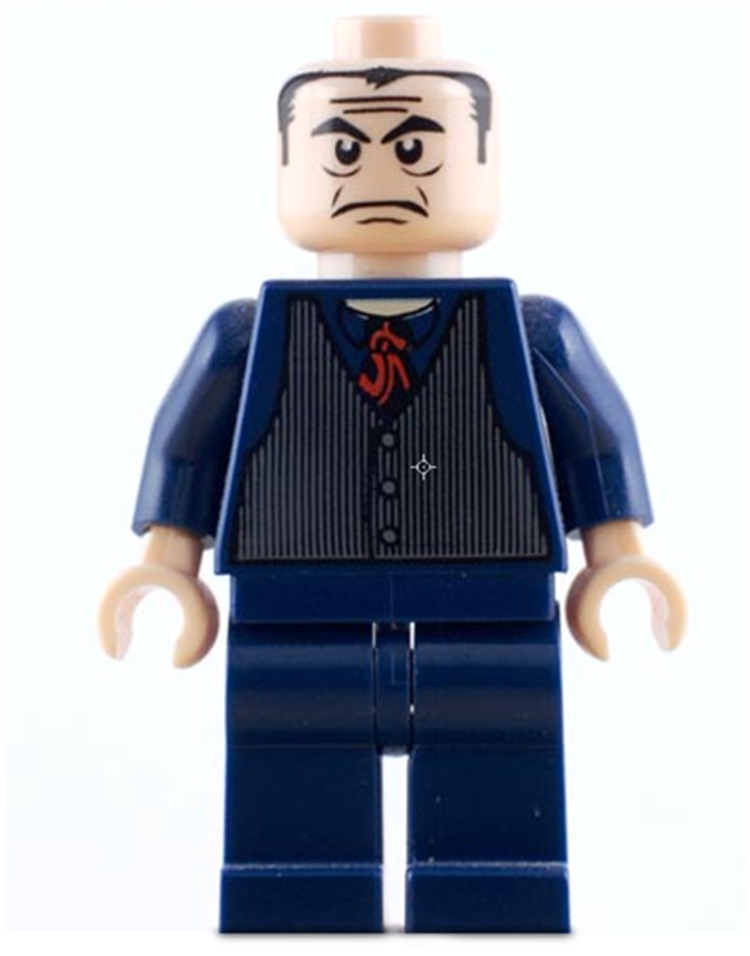
A LEGO Minifigure.